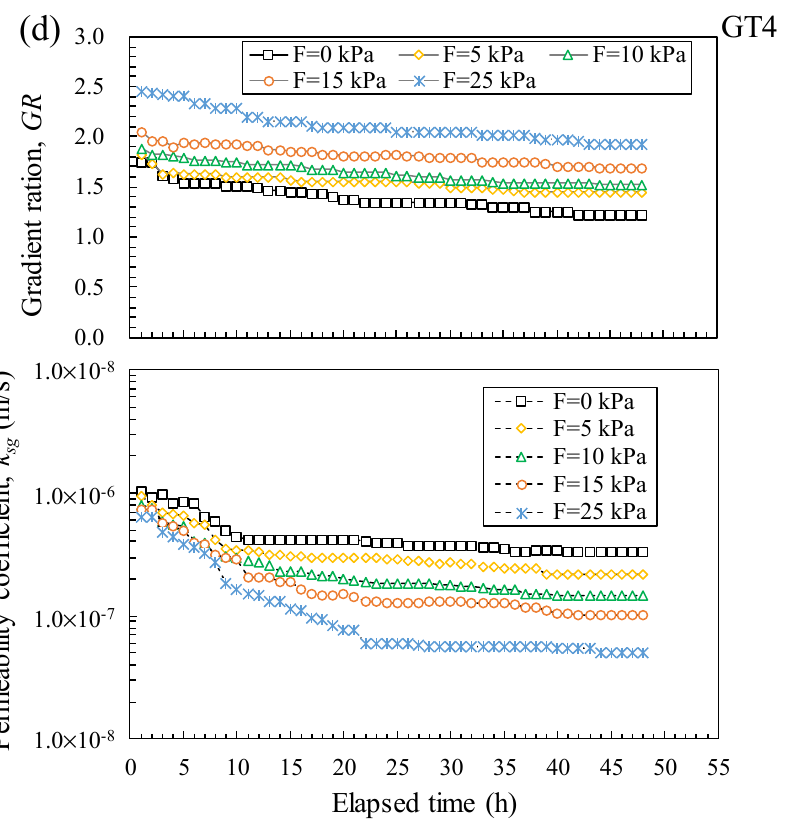
Figure 6. Filtration test results for silt with four geotextiles: ( a ) M-GT1 combination; ( b ) M-GT2 combination; ( c ) M-GT3 combination; ( d ) M-GT4 combination.